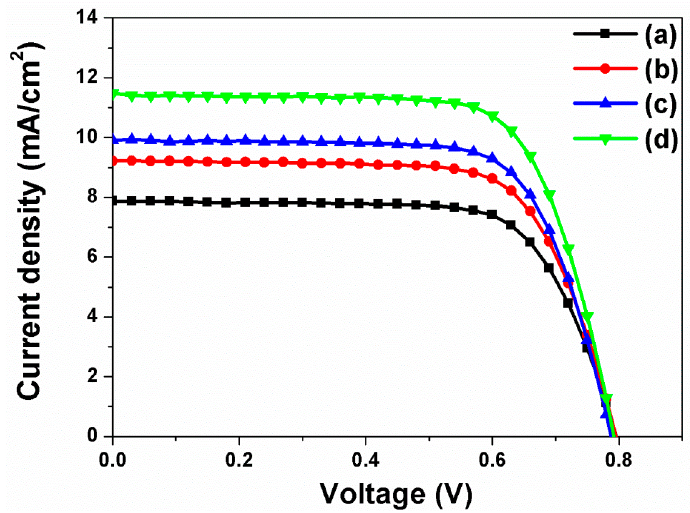
Figure 4. Current density-voltage ( I - V ) curves of DSSCs based on closed-ended freestanding TiO 2 nanotube arrays: ( a ) Without carbon materials and large TiO 2 NPs; ( b ) With carbon materials; ( c ) With large TiO 2 NPs; and ( d ) With carbon materials and large TiO 2 NPs. Table 1. Photovoltaic properties of DSSCs based on closed-ended freestanding TiO 2 nanotube arrays with/without carbon materials and with/without large TiO 2 NPs.